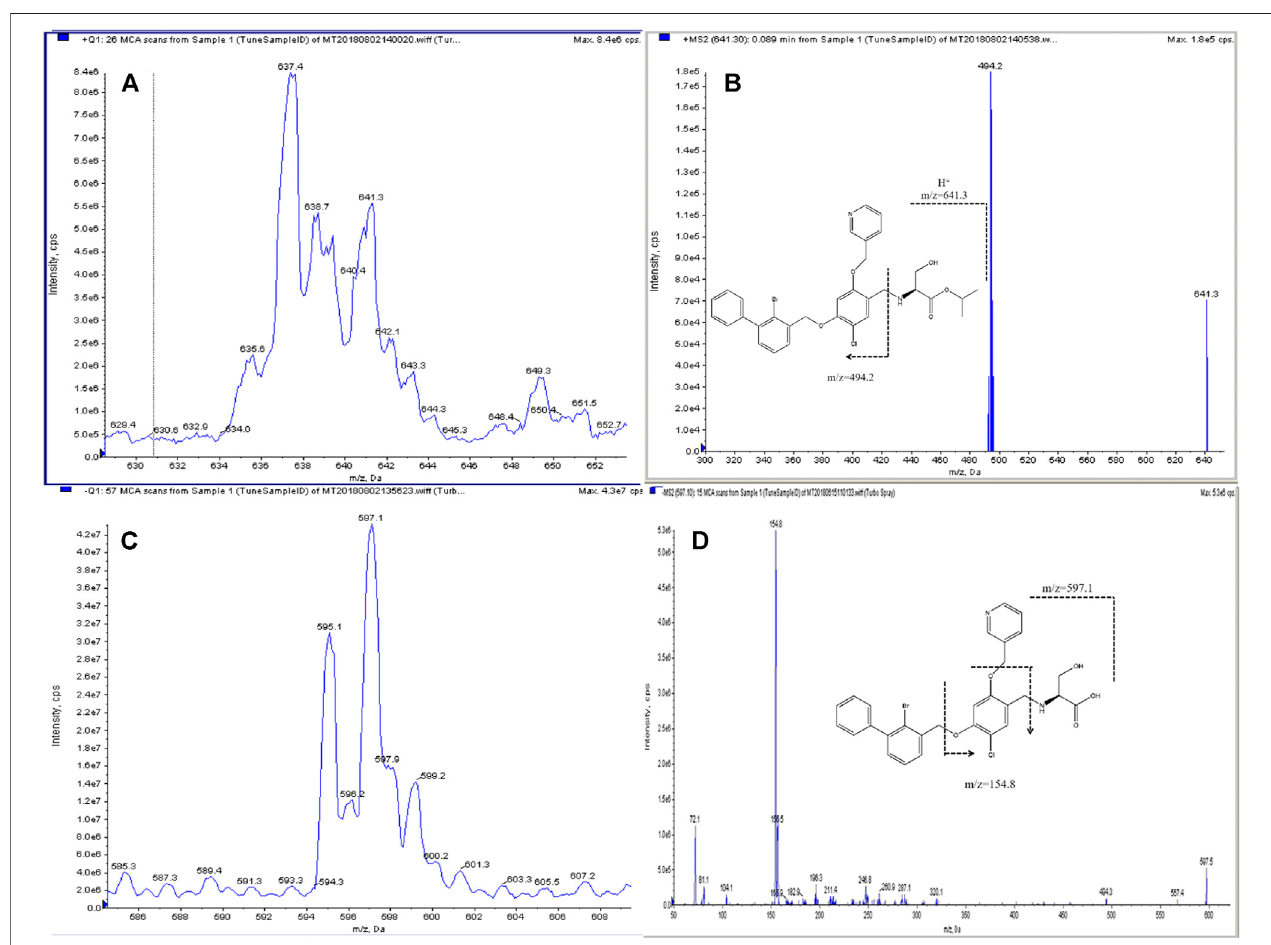
FIGURE 1 | Structure and product ion spectra with proposed MS fragmentations: parent ion (A) and daughter ion (B) of IMMH-010 and parent ion (C) and daughter ion (D) of YPD-29B.